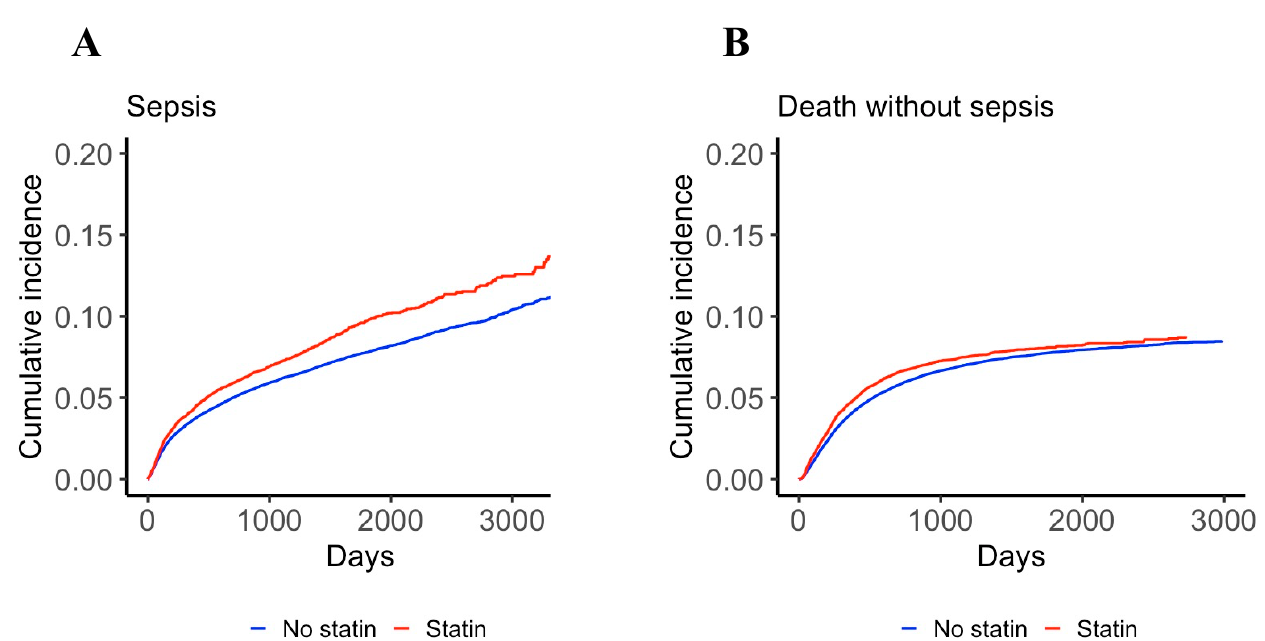
Figure 1. Cumulative incidence of sepsis (panel A ) and death without sepsis (treated as a competing event, panel B ) in patients with a new cancer diagnosis receiving or not receiving statins prior to cancer diagnosis. Table 3. Summary of the Fine and Gray model assessing the effect of covariates on the hazard of sepsis, treating death without sepsis as a competing